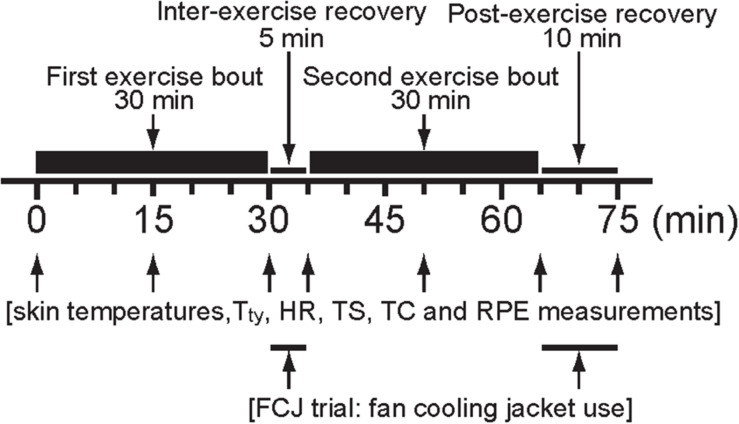
Schematic representation of the experimental protocol. Tty, infrared tympanic temperature; HR, heart rate; TS, thermal sensation; TC, thermal comfort; RPE, rating of perceived exertion.